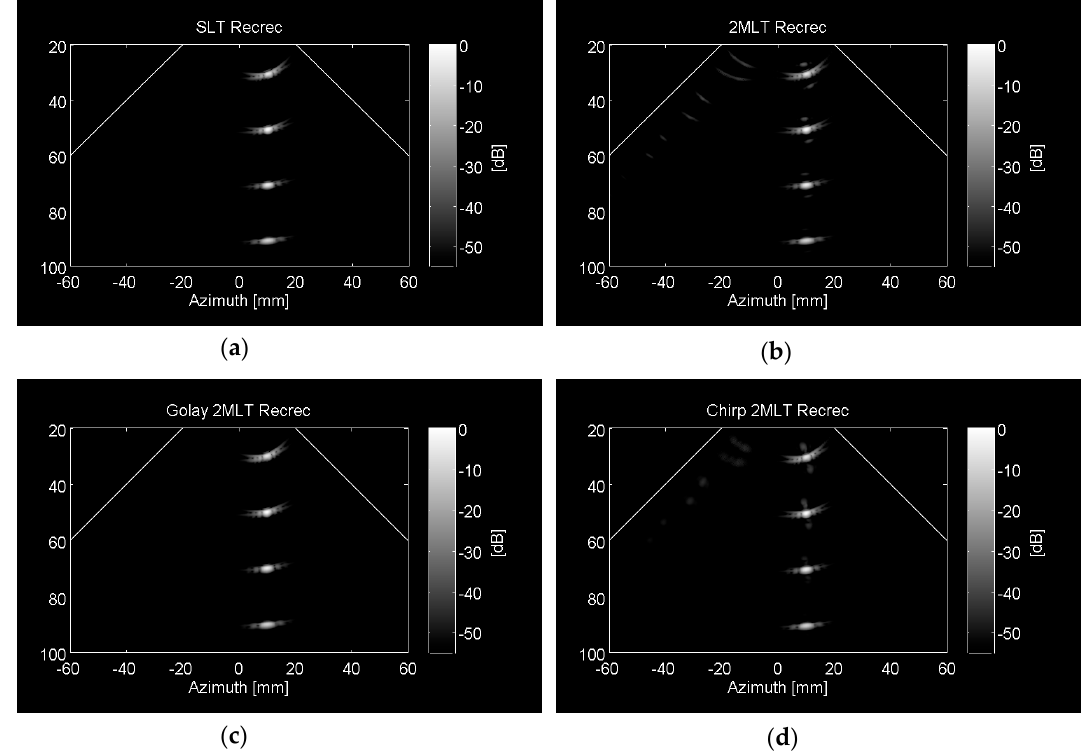
Figure 6. Point-spread-function (PSF) of different MLT schemes without apodization on transmit and receive. ( a ) SLT (single line transmit i.e., 1MLT) scheme with non-coded excitation as the reference image, ( b ) 2MLT scheme using non-coded excitation with crosstalk artifacts, ( c ) 2MLT scheme using Golay coded excitation without crosstalk artifacts, and ( d ) 2MLT scheme using chirp coded excitation with slight crosstalk artifacts. A dynamic range of 55dB was used.